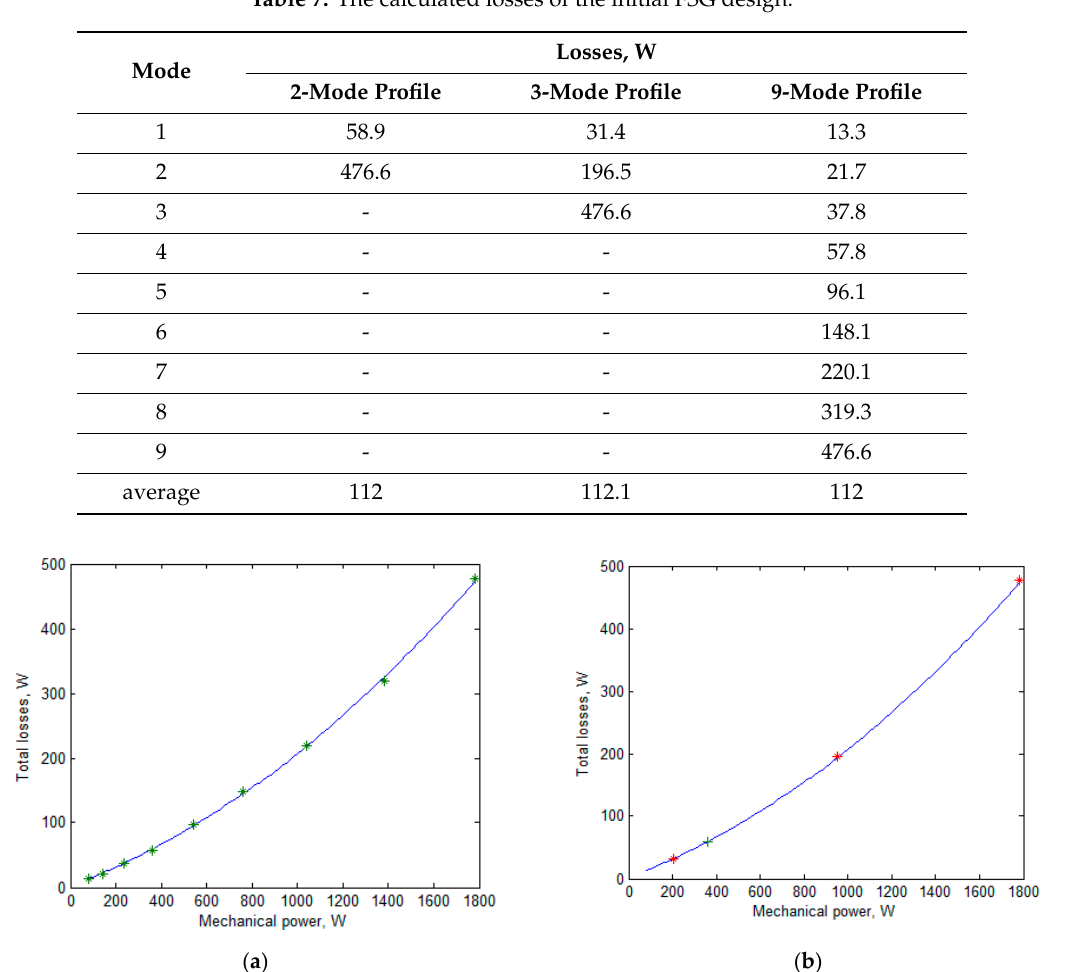
Table 7. The calculated losses of the initial FSG design.